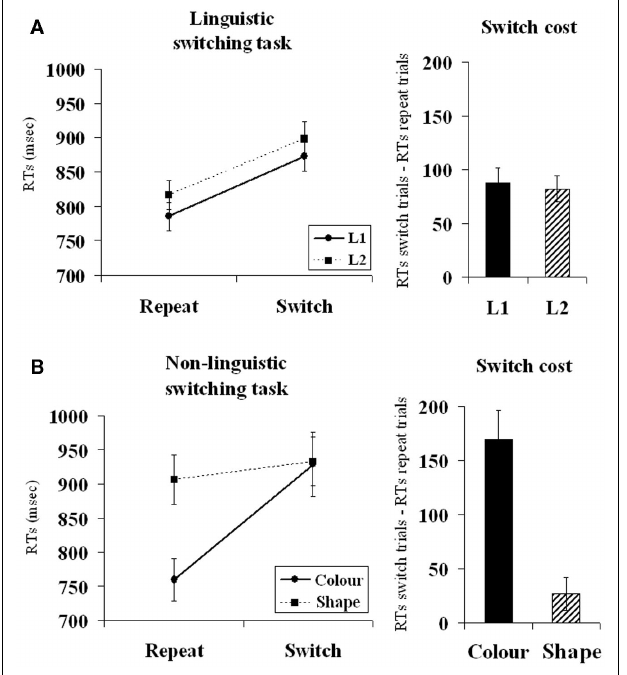
FIGURE 1 | (A) Performances on the linguistic switching task (left) and magnitude of the switch cost for L1 and L2 (right). Error bars represent SE. (B) Performances on the non-linguistic switching task (left) and magnitude of the switch cost for color and shape (right). Error bars represent the